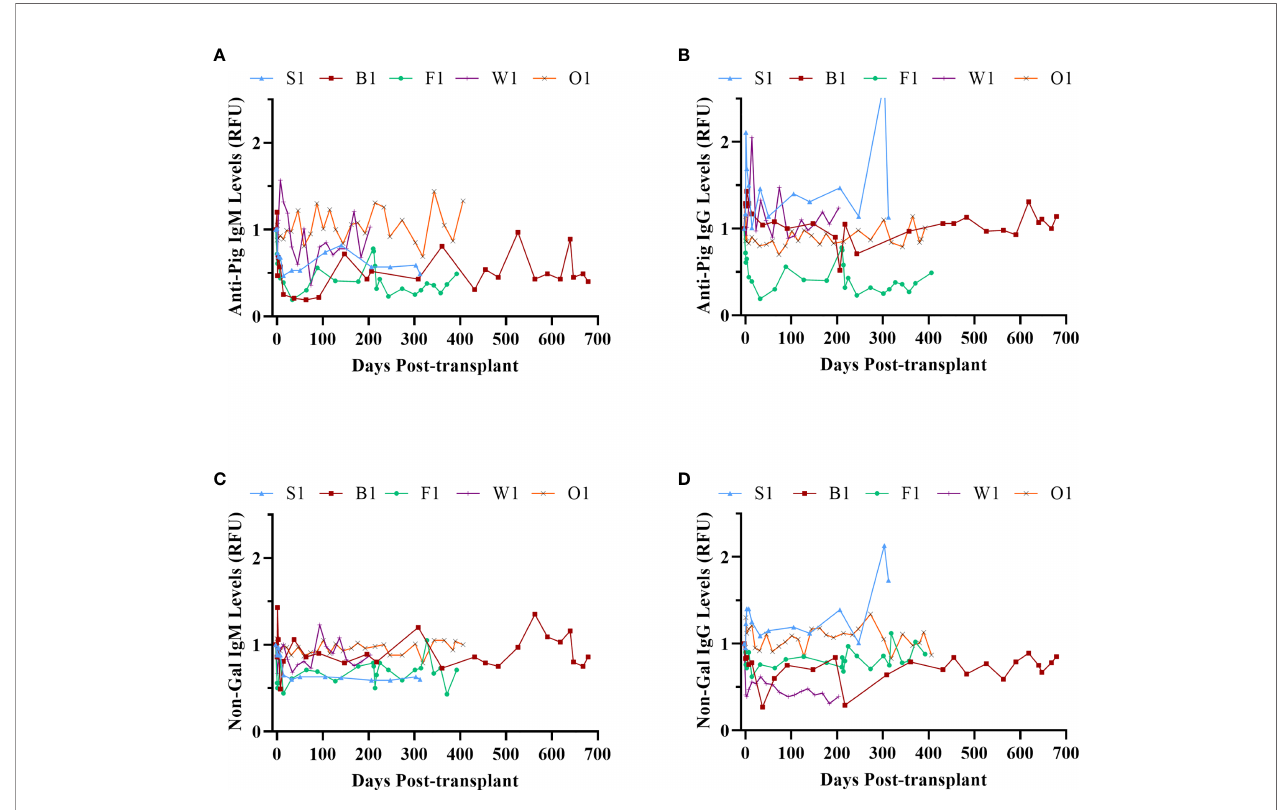
FIGURE 9 | Xenoreactive antibody levels. Anti-pig IgM (A) and IgG (B) ; anti-non-Gal IgM (C) and IgG (D) .